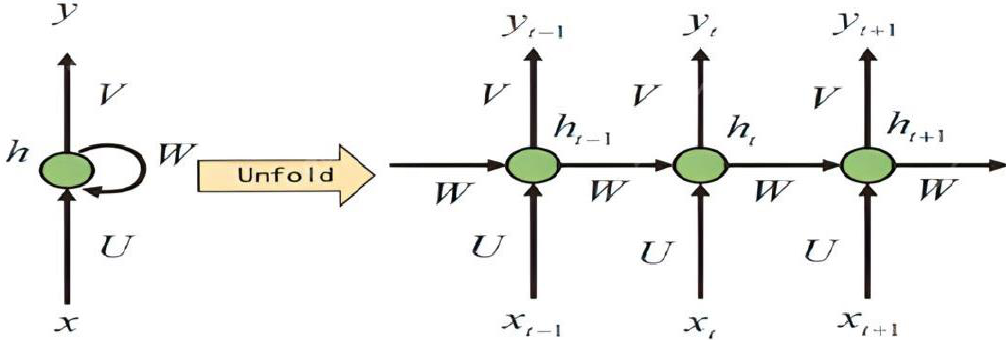
Figure 4. An illustration of the RNN model.